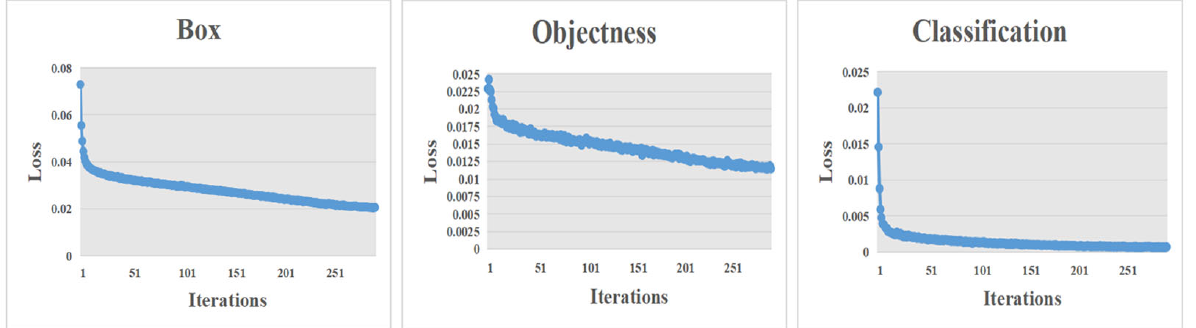
Figure 9. Variation curves of loss values on the URPC dataset.